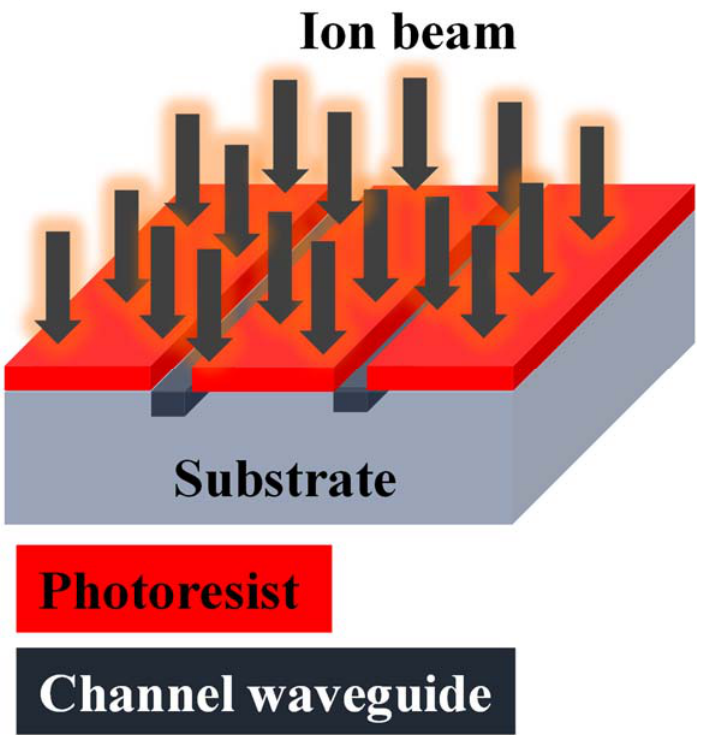
Figure 6. Schematic illustration of the channel WG manufacturing procedure via ion-implantation.